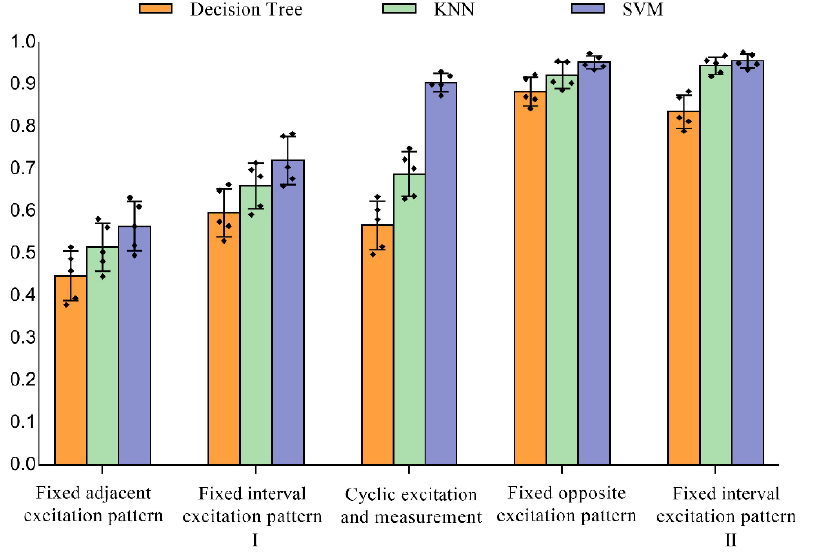
Figure 9. Classification results of normal measurement data under different excitation drive patterns, the vertical lines depict the respective 95% confidence intervals, the black squares in the figure represent the distribution of sample points.